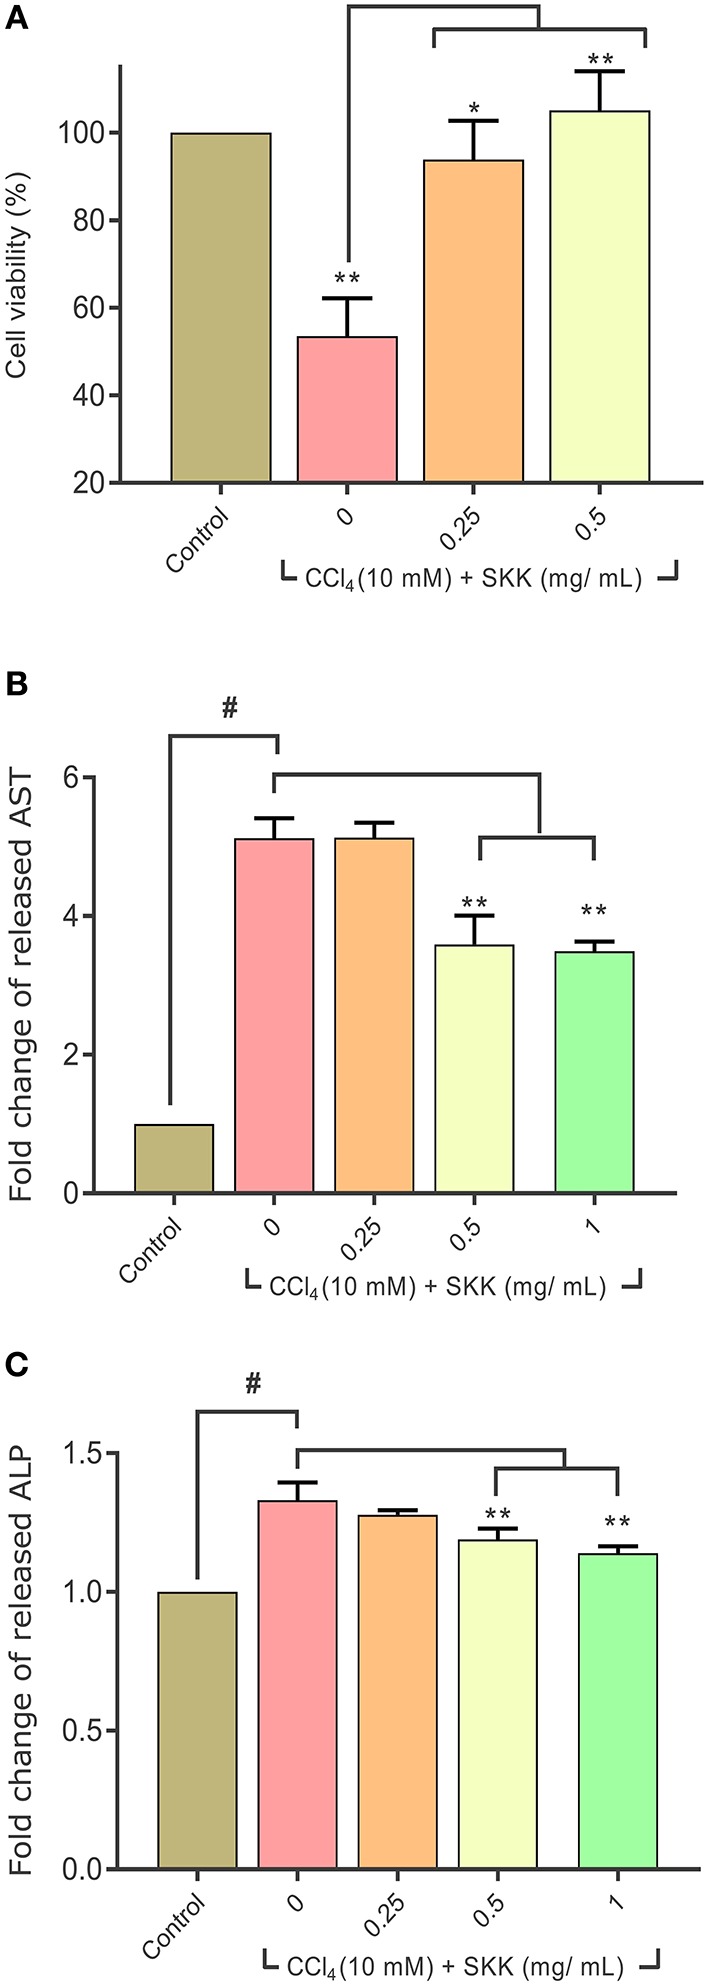
In-vitro analysis of cellular and biochemical effects of Divya Sarva-Kalp-Kwath (SKK): (A) significant loss of cell viability was observed following the stimulation of HepG2 cells with 10 mM of CCl4. Co-treatment of the CCl4 stimulated HepG2 cells with SKK led to a significant recovery of cell viability. Also, CCl4 stimulation of the HepG2 cells led to an augmented release of liver injury serum-based biomarkers, (B) aspartate aminotransferase (AST), and (C) alkaline phosphatase (ALP). Release of these serum hepatotoxicity biomarkers was ameliorated following co-treatment of the CCl4 stimulated HepG2 cells with SKK (0.5 and 1 mg/mL). Results are expressed as mean ± standard deviation. One-way analysis of variance (ANOVA) followed by Dunnett's multiple comparison t-test was used to calculate the statistical difference. p-value *<0.05; **<0.01; #<0.01.